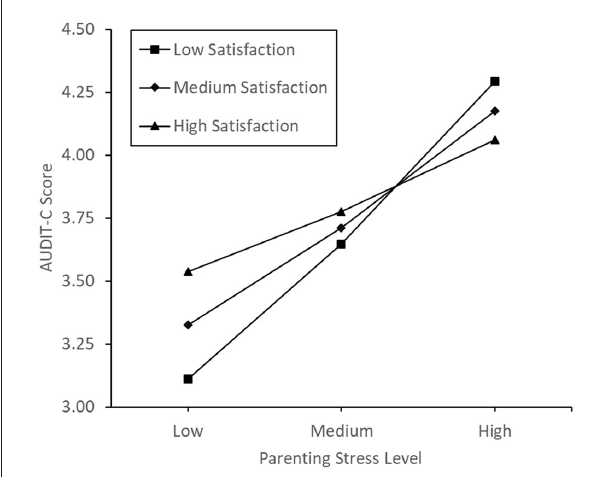
FIGURE 3 | Conditional effects of parenting satisfaction on the correlation between parenting stress and alcohol